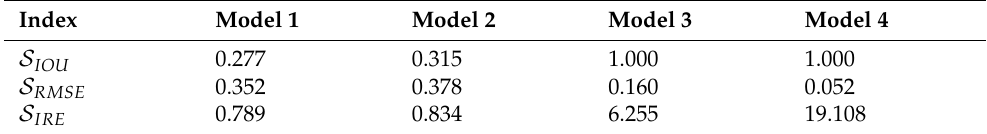
Table 1. Evaluation indexes of inversion results.